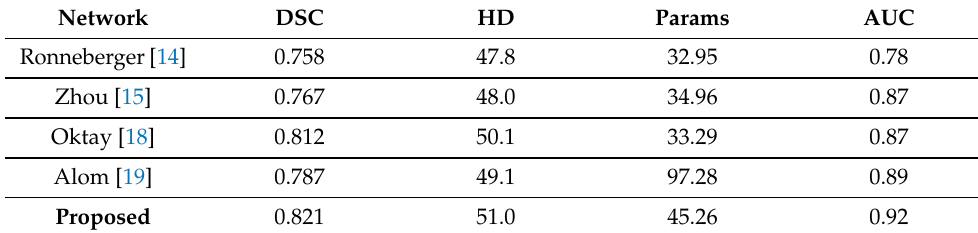
Figure 5. Qualitative comparisons ( a ) Histopathology image ( b ) Ground truth ( c ) Nested UNet ( d ) Attention UNet ( e ) RCNN UNet ( f ) MIU-net. Table 2. Experiments in comparison to many traditional